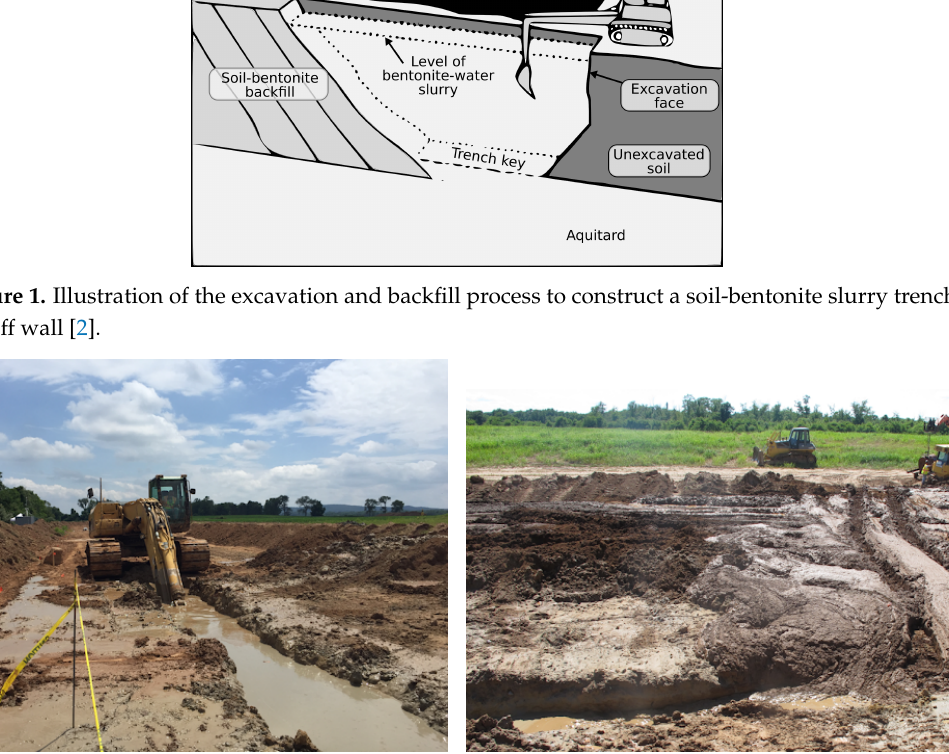
Figure 2. Excavation and Backfill at the test